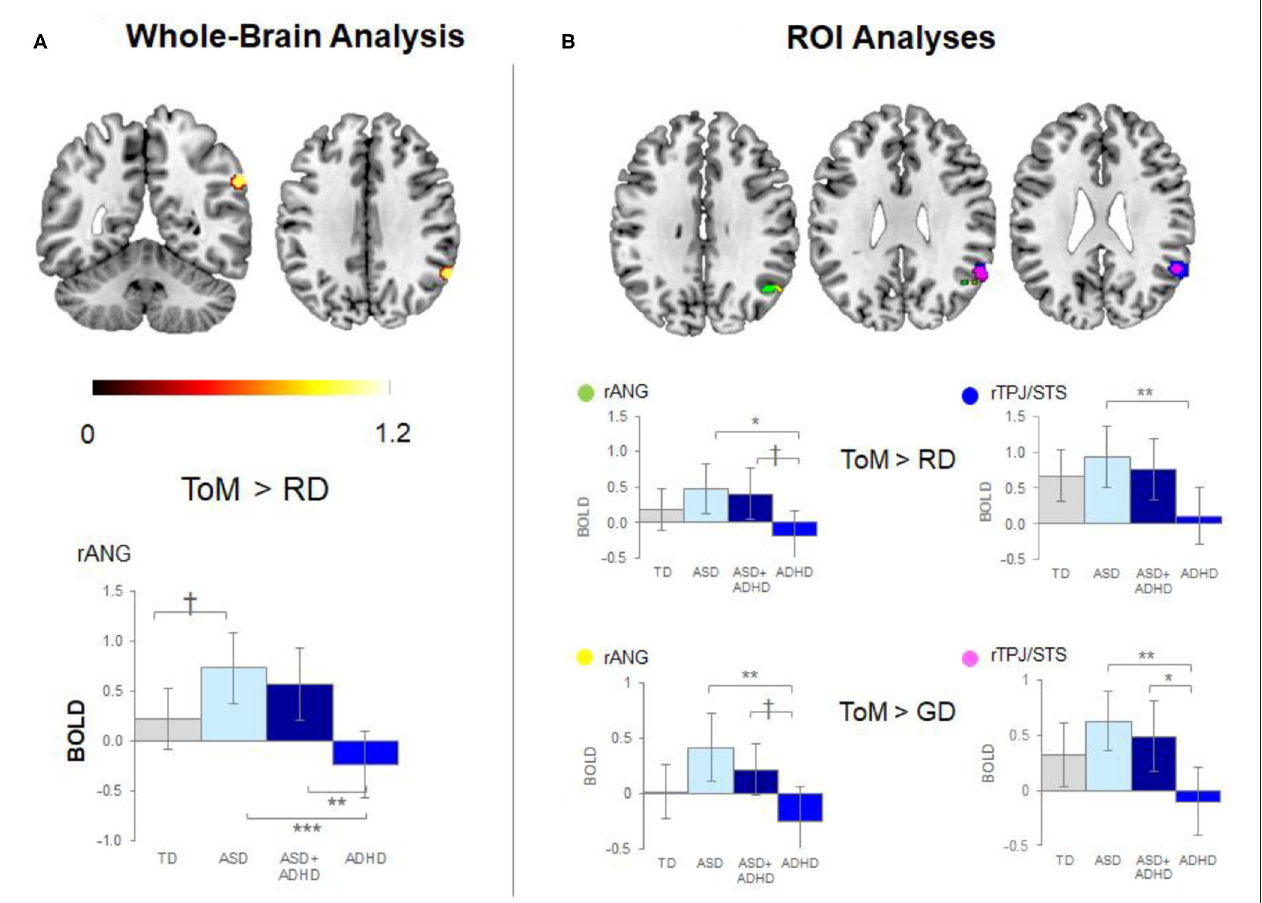
FIGURE 3 | Significant peak activation by clusters and bar graphs showing within pairwise comparisons. (A) Whole-brain analysis and (B) Region of interest (ROI) analyses. TD, typical development; ASD, autism spectrum disorder; ADHD, attention-deficit/hyperactivity disorder; BOLD, blood-oxygen-level dependent; GD, goal directed; RD, random movement; ToM, theory of mind; rANG, right angular gyrus; rTPJ/STS, right temporoparietal junction/superior temporal sulcus * p < 0.05, ** p < 0.01, *** p < 0.001, † p < 0.1 with Tukey–Kramer multiple comparison